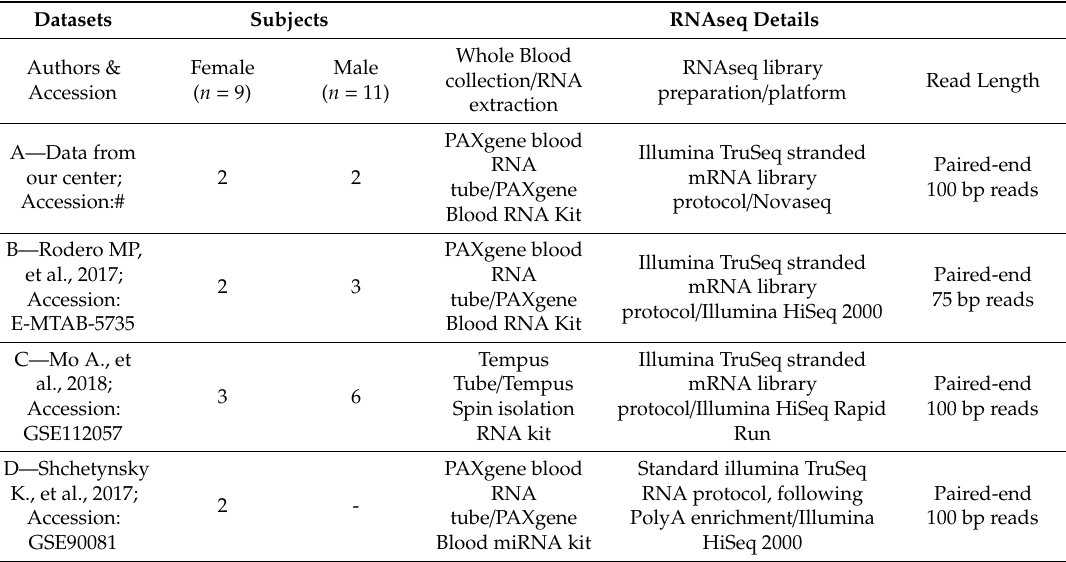
Figure 4. Overall ISGs expression variance between individuals. PCA of the first selection ( a ), with evidence of the three outliers from Dataset C, and of the final twenty-controls-sized group ( b ), showing twenty samples uniformly distributed (4 from Dataset A, 5 from Dataset B, 9 from Dataset C and 2 from Dataset D). Table 4. Detailed report of final twenty-controls-sized healthy subject groups.